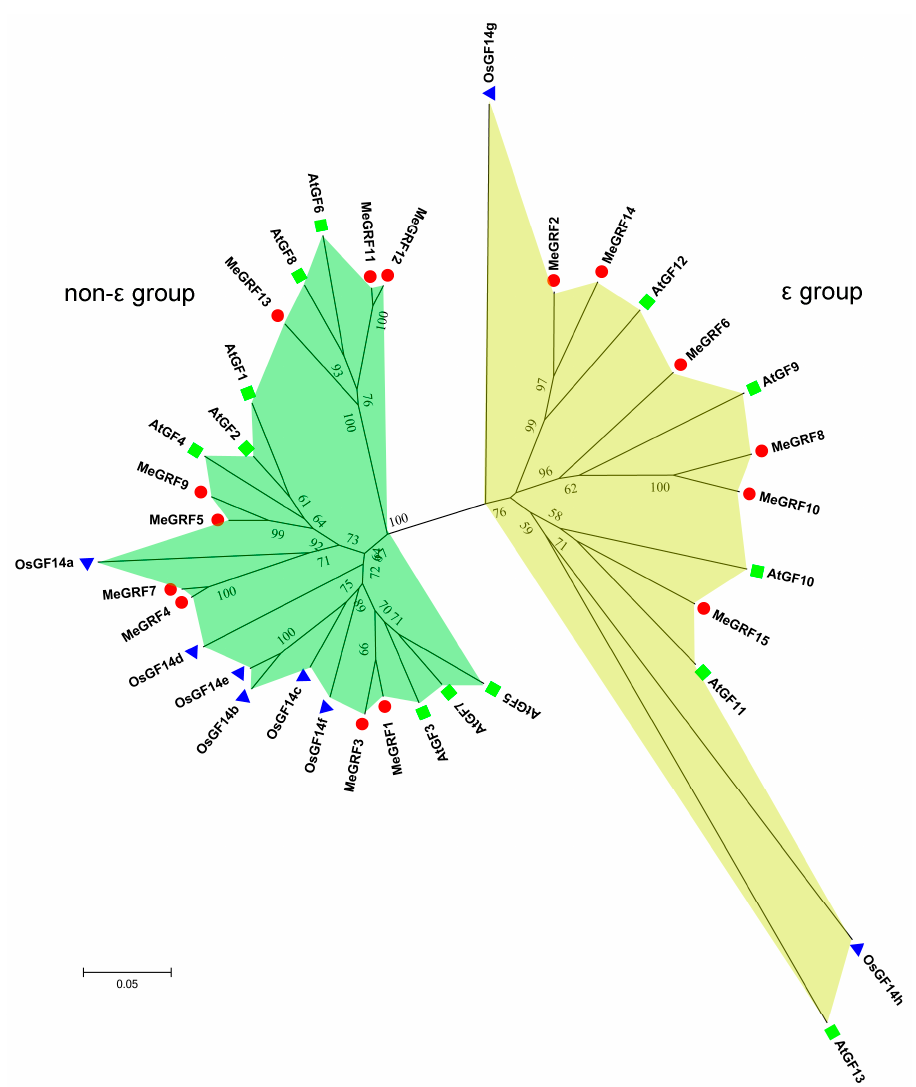
Figure 1. Phylogenetic analysis of the GENERAL REGULATORY FACTOR proteins (GRFs) from Arabidopsis , rice, and cassava. The neighbor-joining phylogenetic tree was constructed using ClustalX 2.0 and MEGA5.0 with 1000 bootstraps replicates [41,42].